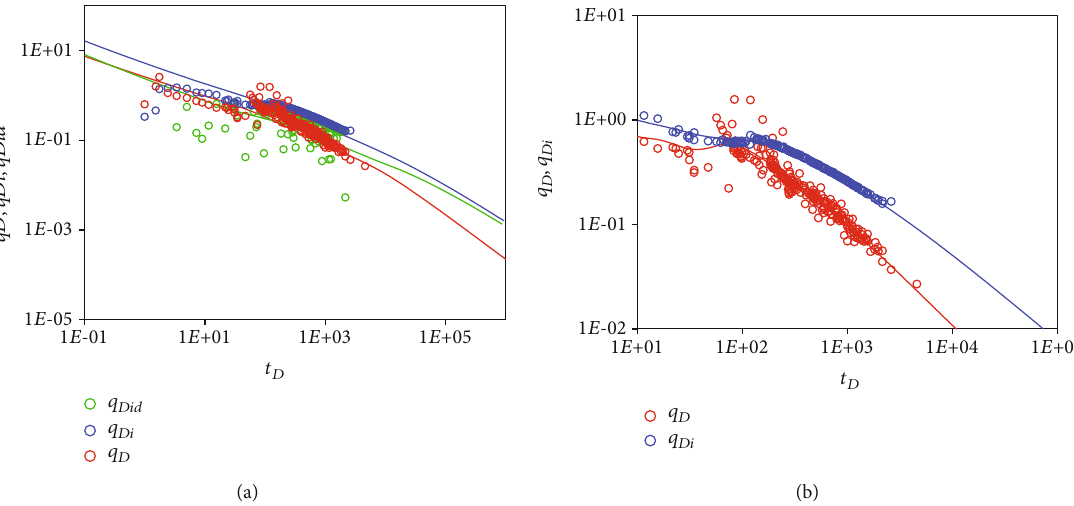
Figure 16: Type curve fi tting of YY-4 production data considering (a) and ignoring (b) the uneven support of